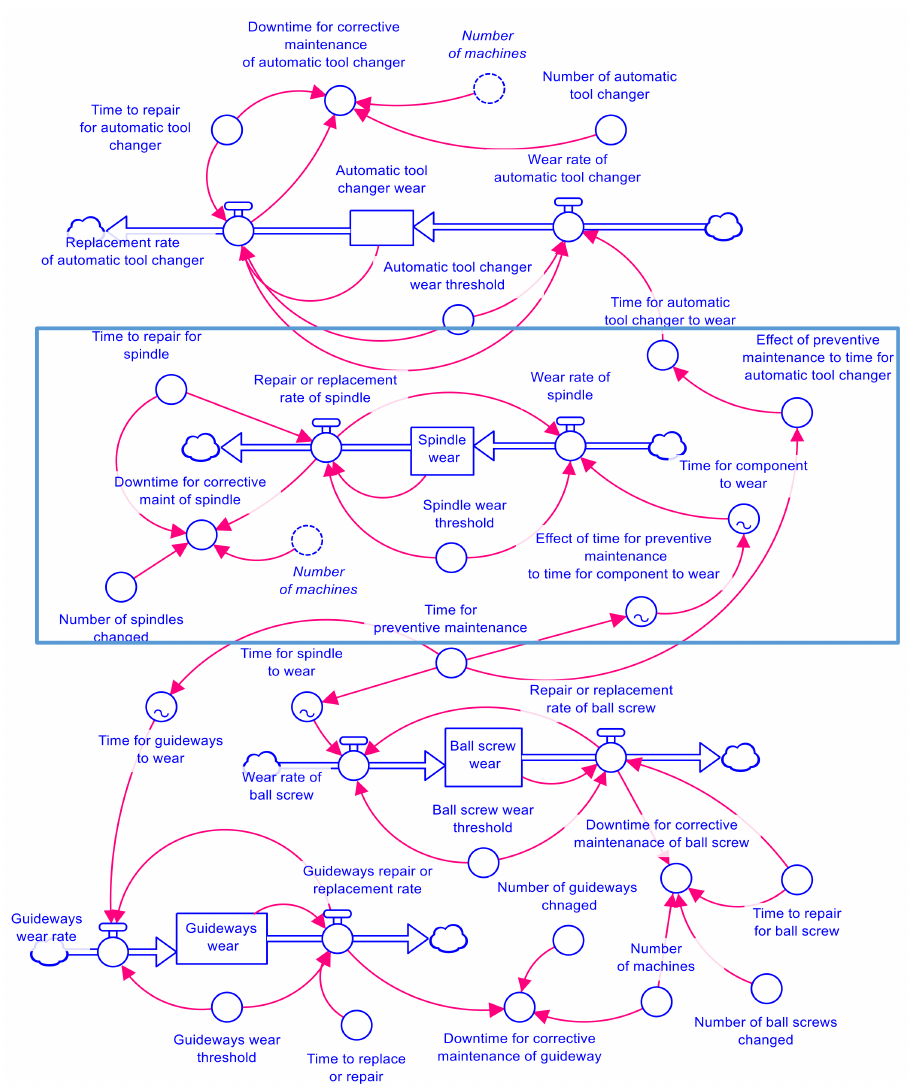
Figure 14. Structure of maintenance